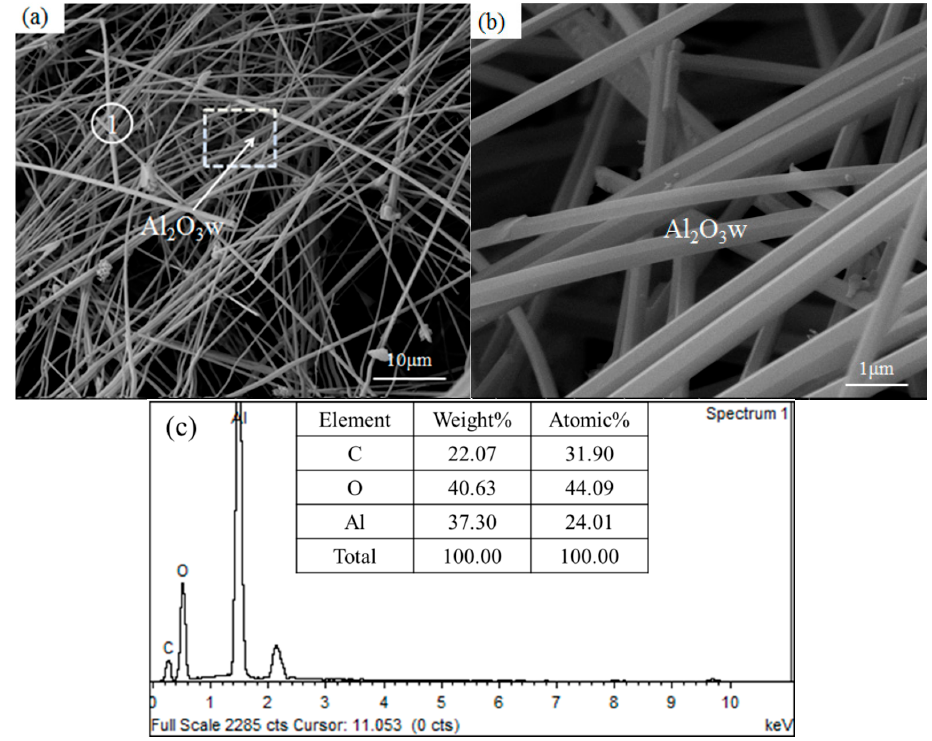
Figure 5. SEM images ( a , b ) and EDS spectrum ( c ) of the as-synthesized samples: Al 2 O 3 w means Al 2 O 3 whiskers. Al 2 O 3